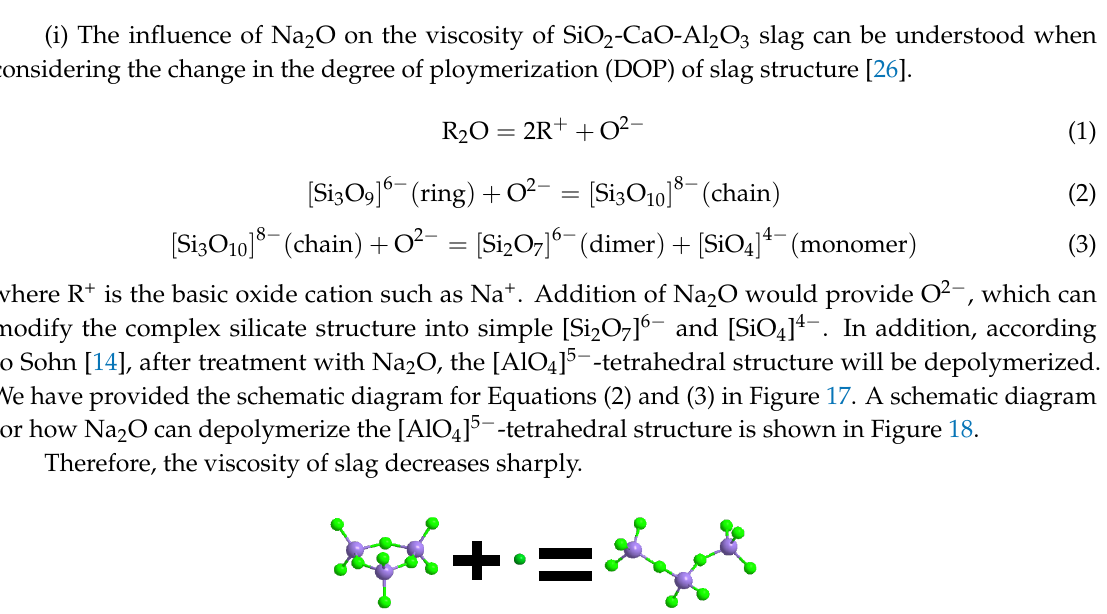
Figure 16. ( a ) Chains; ( b ) Rings; ( c ) Three-dimensional network structure.